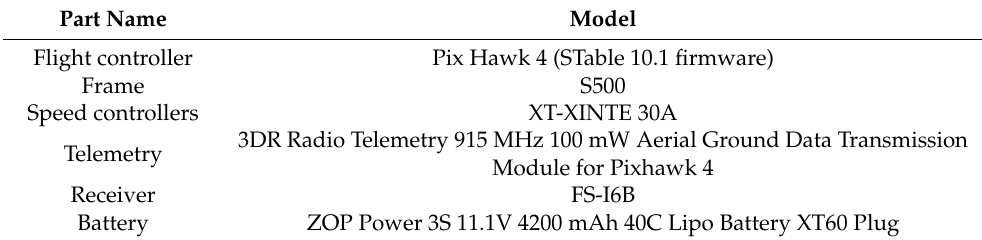
Table 1. Experimental stand